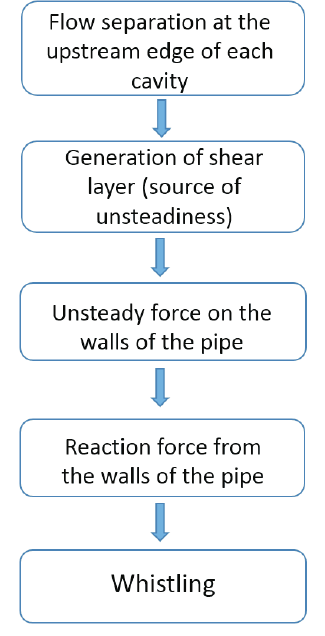
Figure 1. Whistling mechanism in corrugated pipes